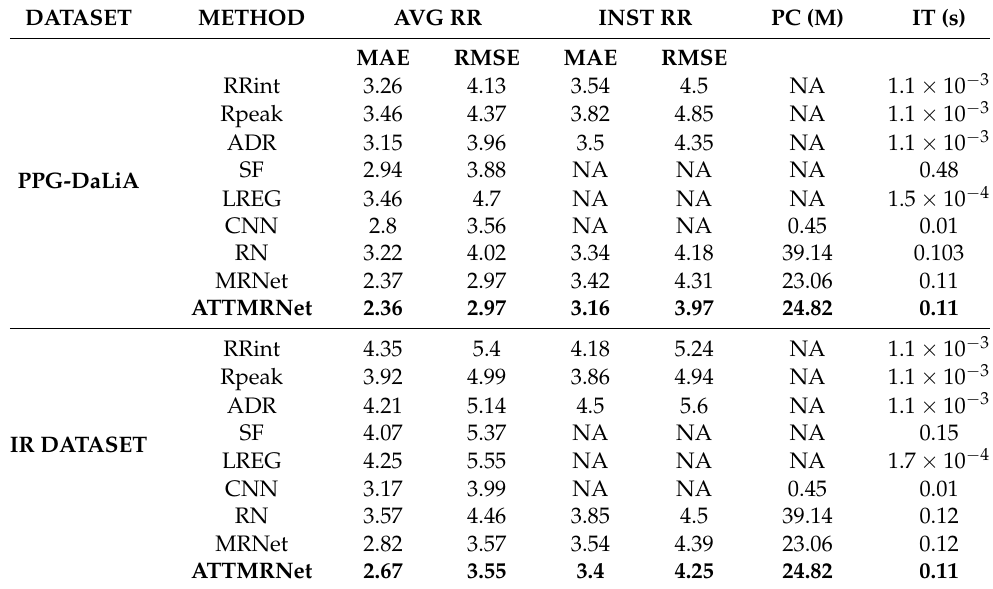
Table 2. Comparison between previously developed works and proposed ATTMRNet.